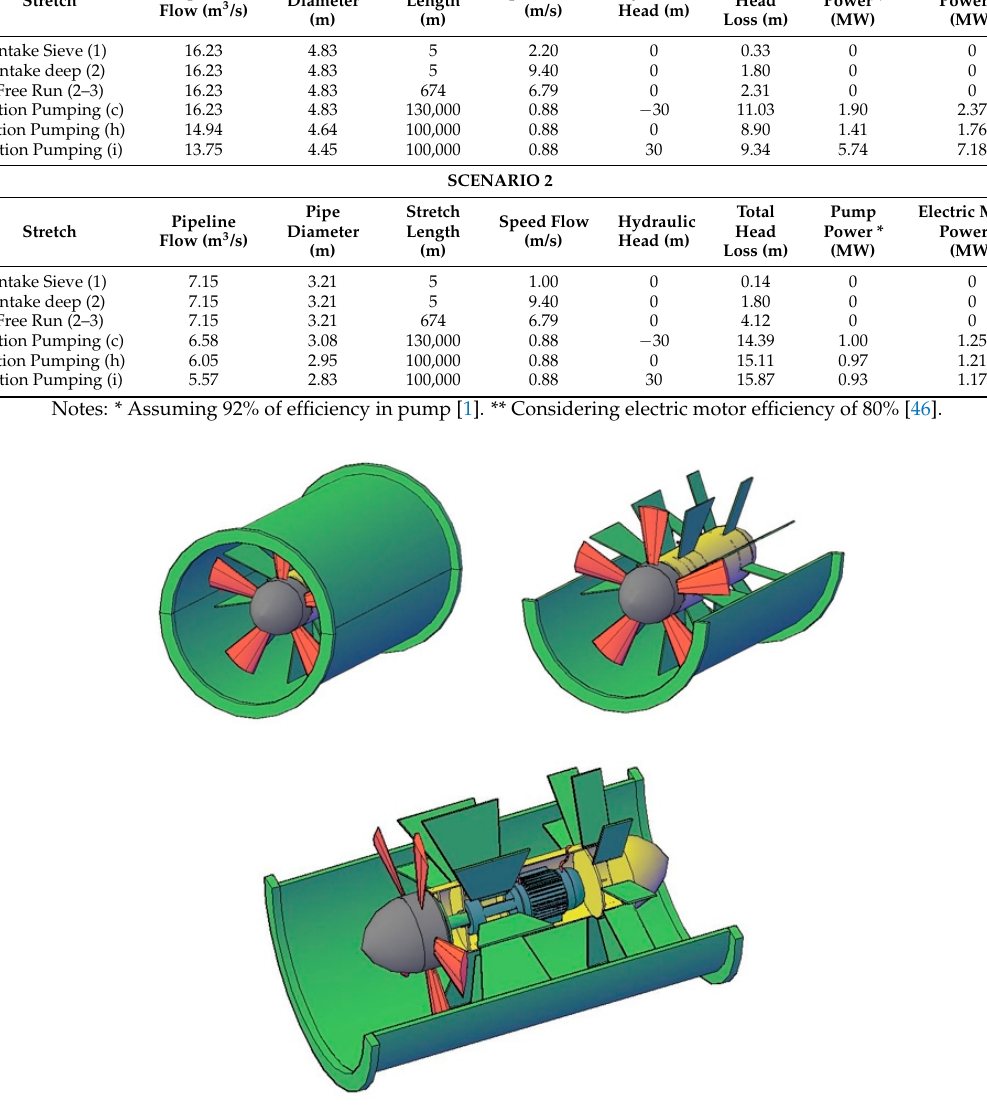
Figure 14. Conceptual design of the proposed axial pump.